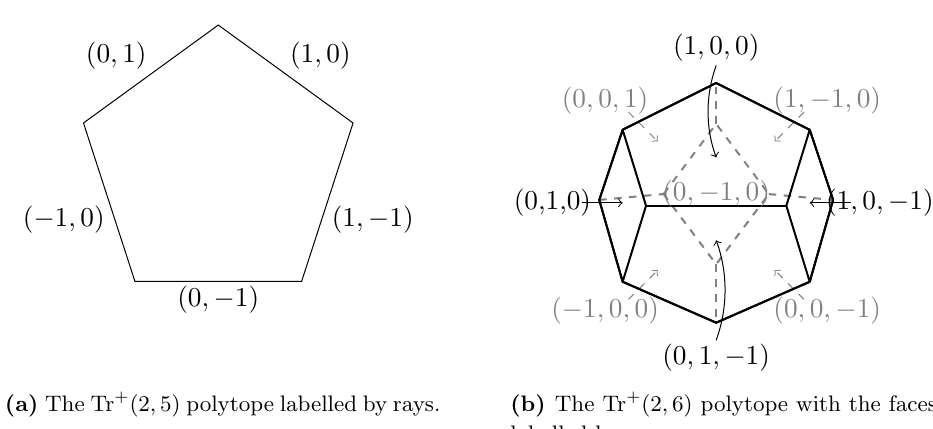
Figure 6 . The cluster polytopes pictured here are the dual polyhedra of those arising from the fans shown in (cid:12)gure